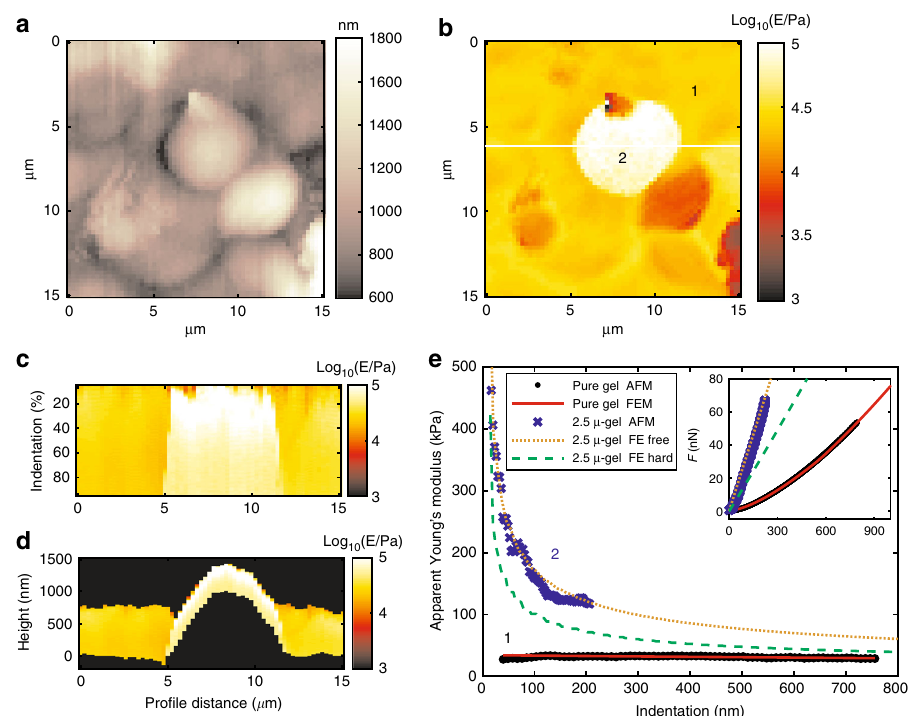
Fig. 4 Graphical results of mechanical analysis by AFMech Suite for 2.5 μ -gel. a Morphology map at zero force, vertical color bar represents height in nm. b Young ’ s modulus map in logarithmic scale at medium indentation (40 – 60% of maximum value). c Qualitative Young ’ s modulus tomography on relative indentation from white line in ( b ). d Qualitative Young ’ s modulus tomography on absolute indentation from line in ( b ). Vertical color bar for ( b – d ) represents logarithm base 10 of Young ’ s modulus in Pa. e Apparent Young ’ s modulus vs. indentation (inset: force vs. indentation) for points 1 and 2 of( b ) comparing AFM results and FEM simulations for boundary conditions: no slip (FE hard) and free to slip (FE free)